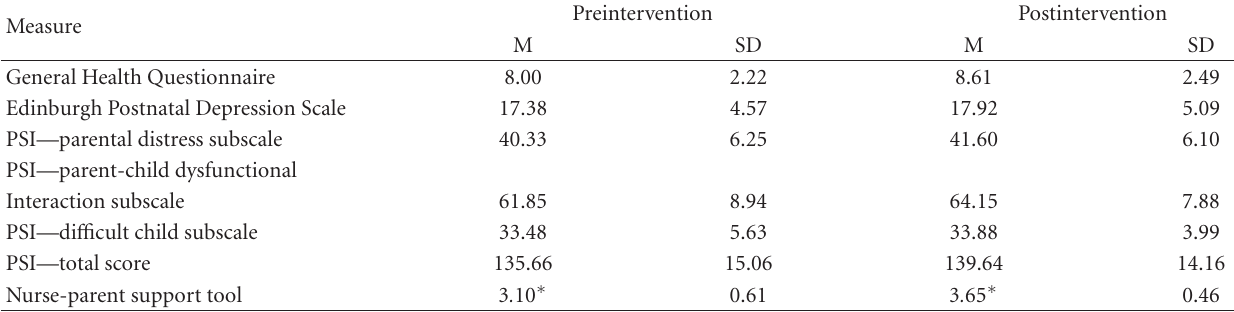
Table 2: Caregiver measures by study phase.